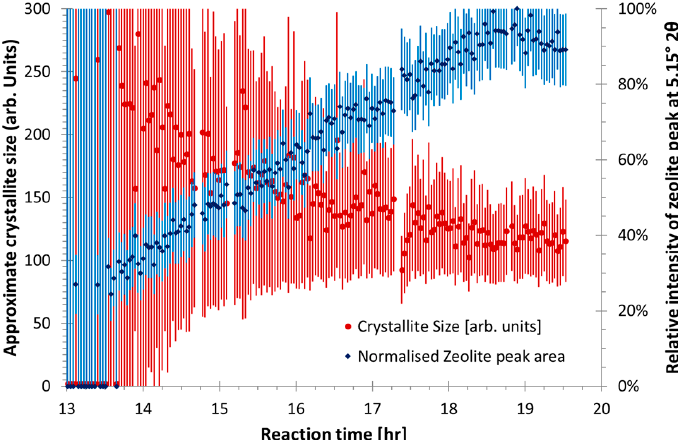
Figure 4. Relative peak area and crystallite sizes of a zeolite-like phase at Q = 1.82 Å − 1 for sample CFA-1.8-0.8-5.5. The peak is of low intensity compared to the background, hence, the noisy signal. The error bars represent 1 estimated standard error from the refinement process.